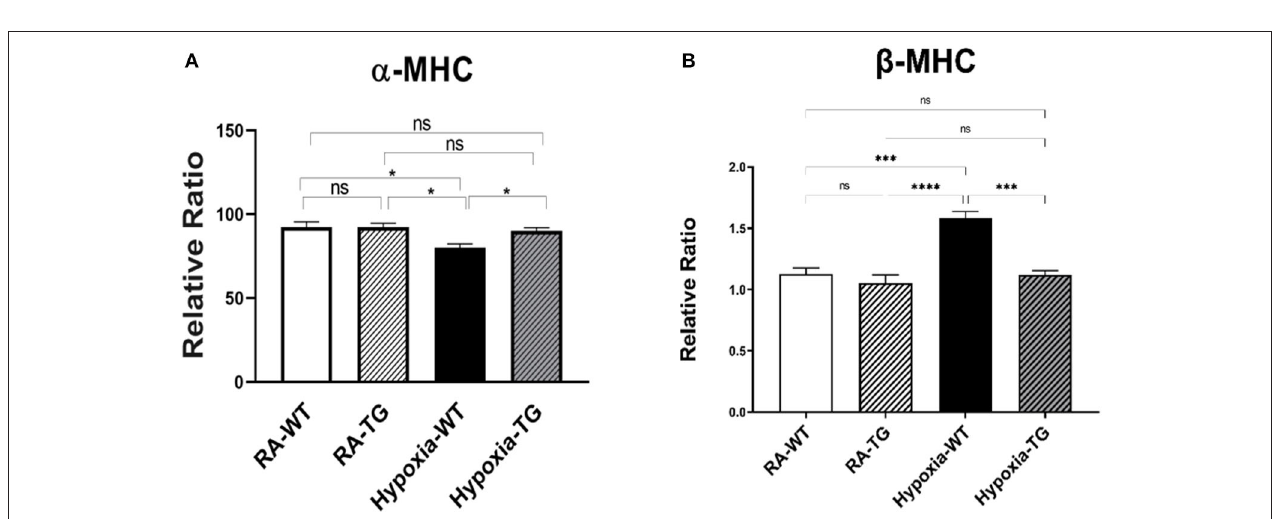
FIGURE 7 | (A,B) RT-PCR for α and β myosin heavy chain. Adult mice (C57B6) (WT) and EC-SOD transgenic mice (TG), were exposed to 10% hypoxia for 21 days (WT). Room air animals were used as control group (RA). Quantitative RT-PCR was used to assess gene expression analysis of α -MHC in the right ventricular tissue. All experiments n = 5. Data represents mean ± SEM. * P < 0.05, ** P < 0.01, *** P < 0.001, **** P <